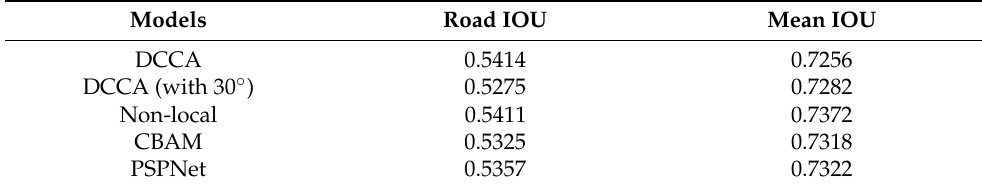
Table 5. The comparison results of other models.